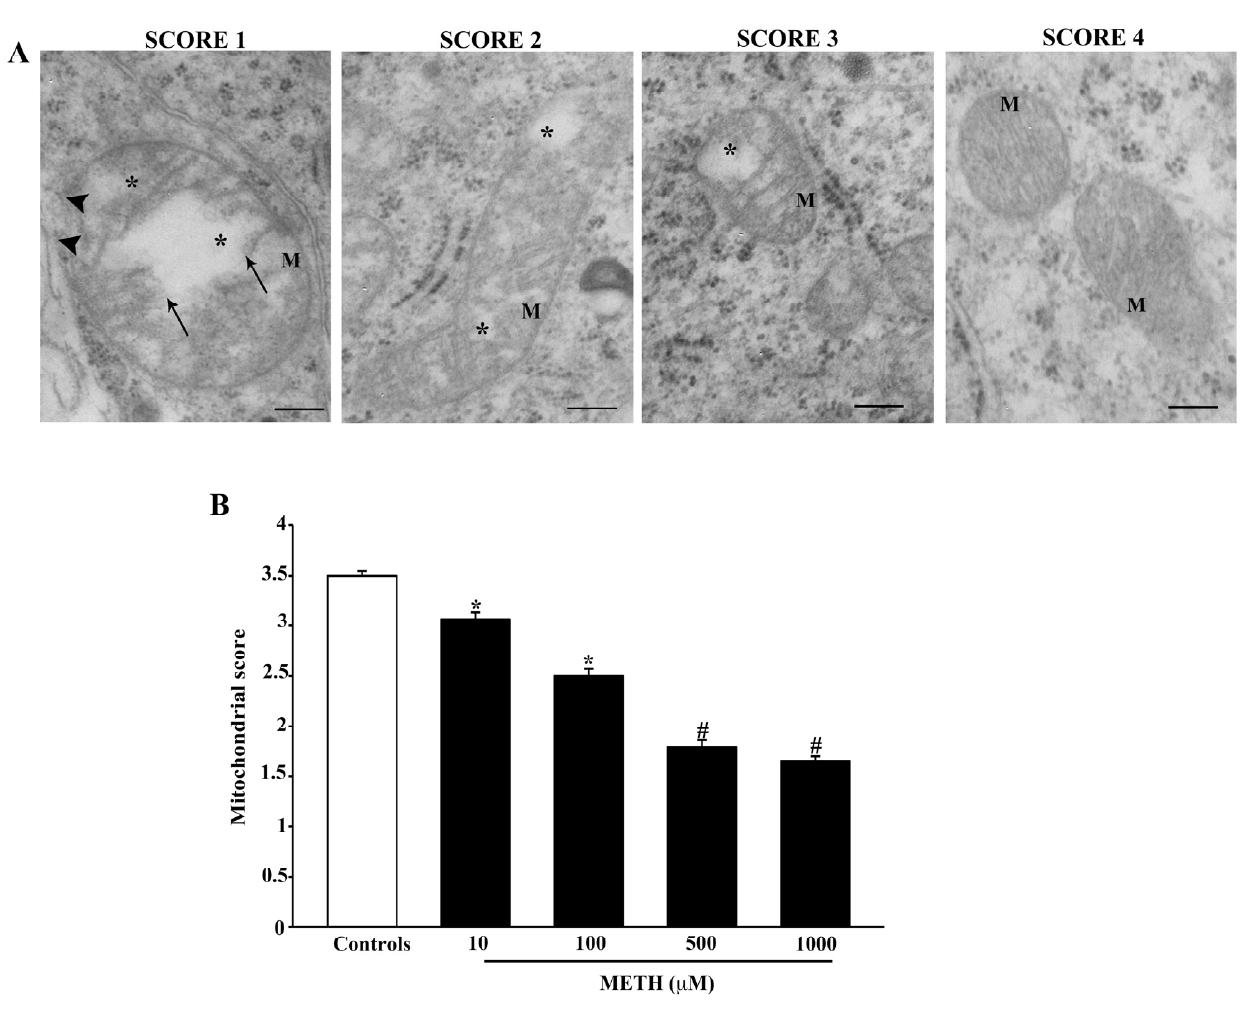
Figure 11. METH decreases the mitochondrial integrity score. ( A ) Representative TEM micrographs showing that METH dose-dependently decreases the integrity of those features used to assess the mitochondrial integrity score. Arrows point to broken crests; arrowheads point to ruptured membranes; * indicates matrix dilution. ( B ) The graph reports the non-parametric mitochondrial integrity score from N = 150 mitochondria per group. Assuming the score as the sum of four non-parametric values, the parametric mean of these values is provided along with its standard error. In this way, the means are compared inferentially. * p ≤ 0.05 compared with controls; # p ≤ 0.05 compared with controls and METH 10 μ M and 100 μ M. Scale bars = 160 nm.